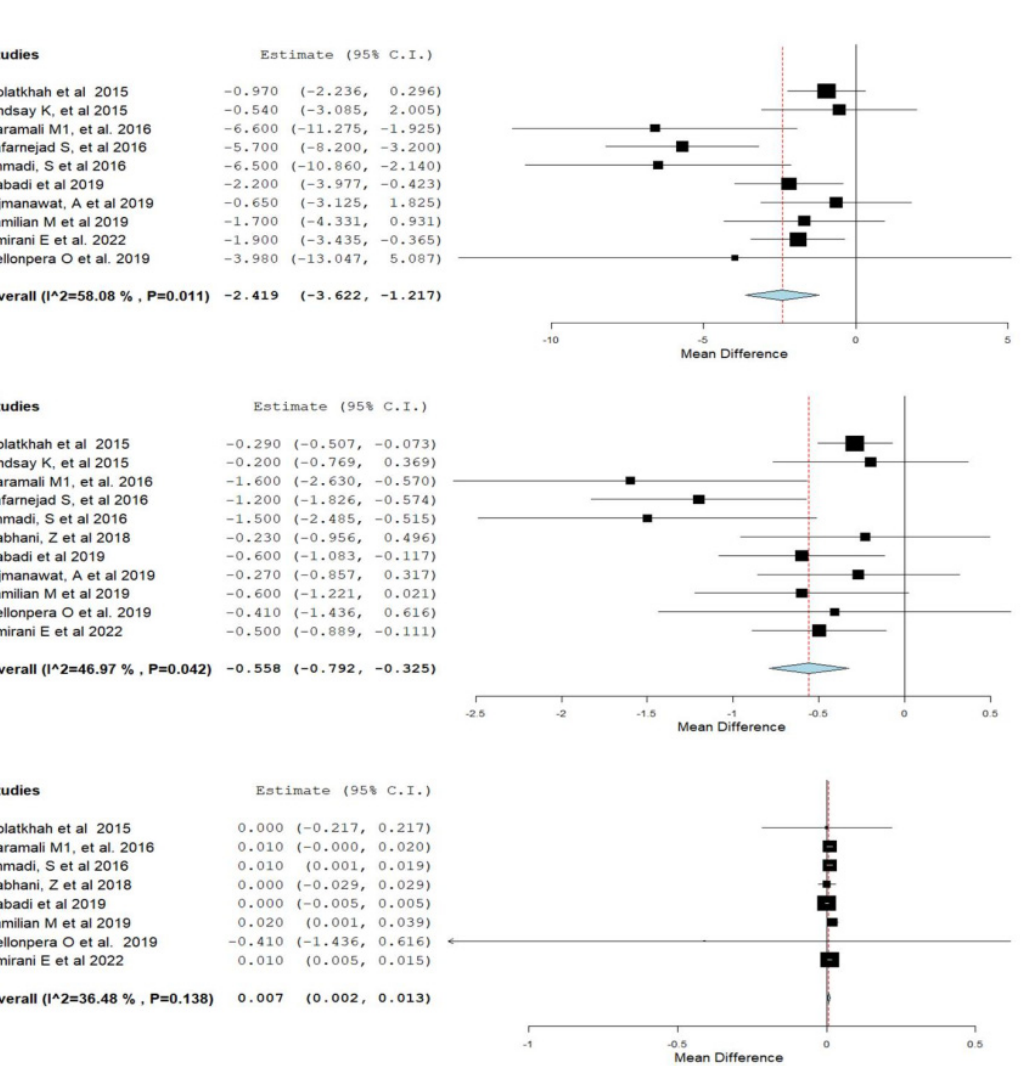
Figure 3. Forest plot of probiotic treatment versus placebo and insulin resistance parameters. ( A ) insulin ( μ IU/mL) [12,14,22,24,25,28,30,31,34,35], ( B ) homeostatic model assessment for insulin resistance (HOMA-IR) [12,14,22,24–26,28,30,31,34,35], and ( C ) the quantitative insulin-sensitivity check index (QUICKI). C.I.: confidence interval [12,22,25,26,28,31,34,35].